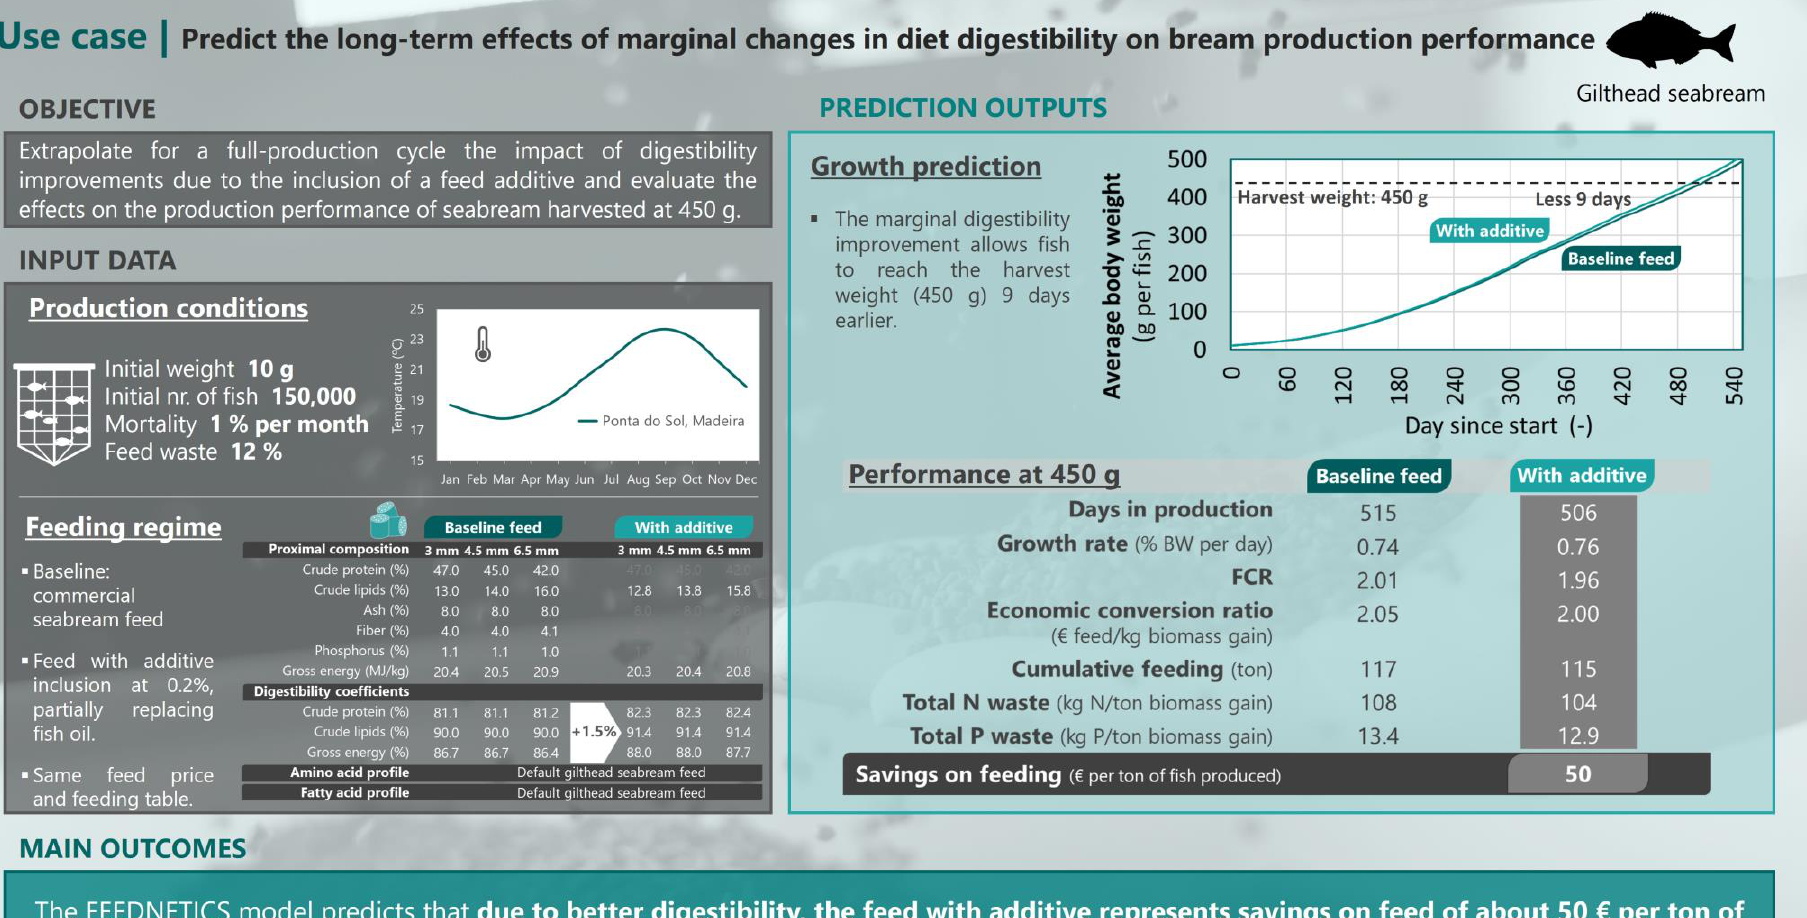
Figure A6. Use case 3: Predict the long-term effects of marginal changes in diet digestibility on bream production performance. All results are model predictions.